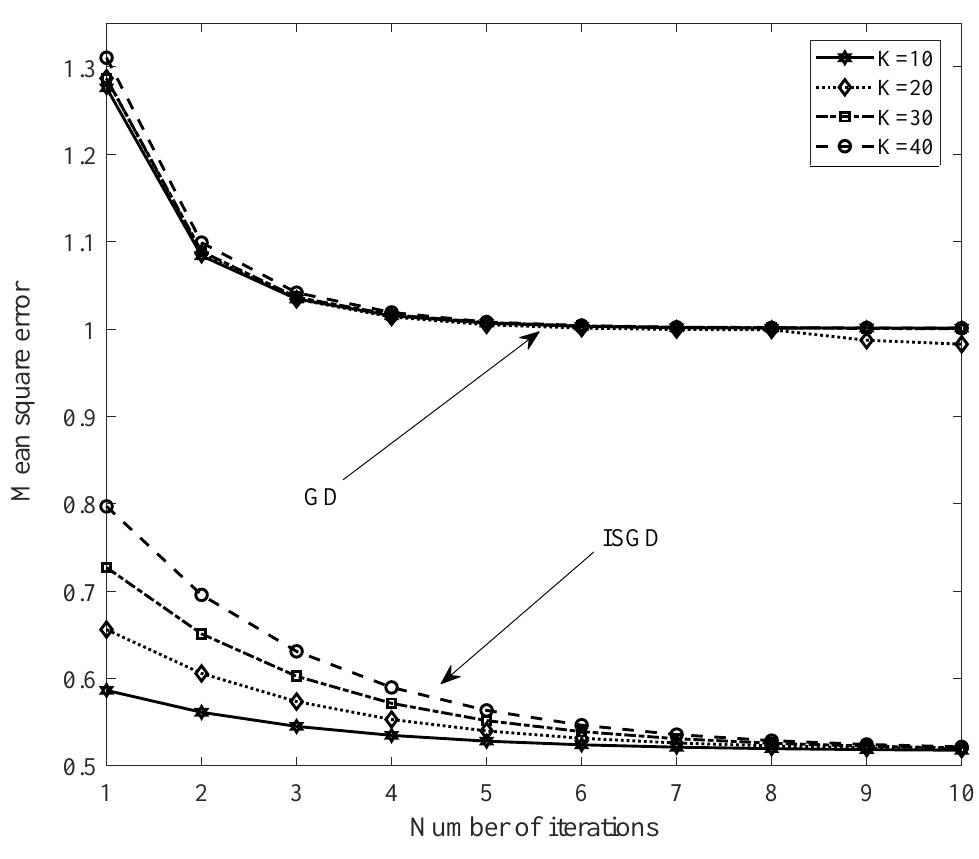
Figure 3. Typical convergence rate of GD and ISGD with varieties of K